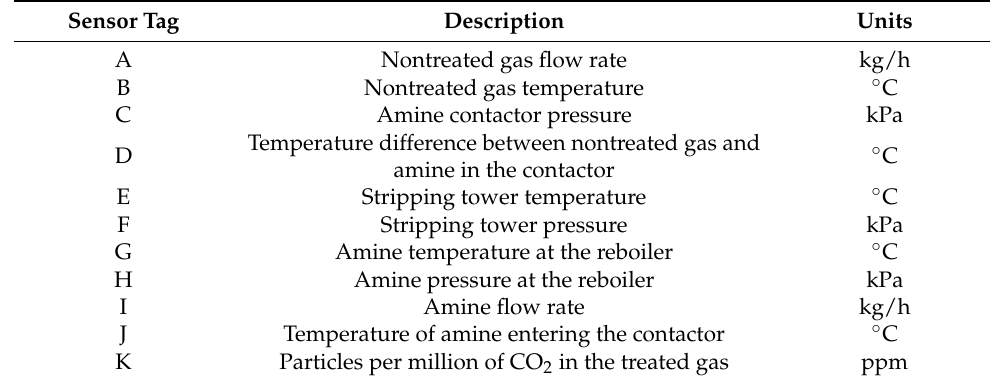
Table 7. Monitored data for natural gas treatment plant. Source: